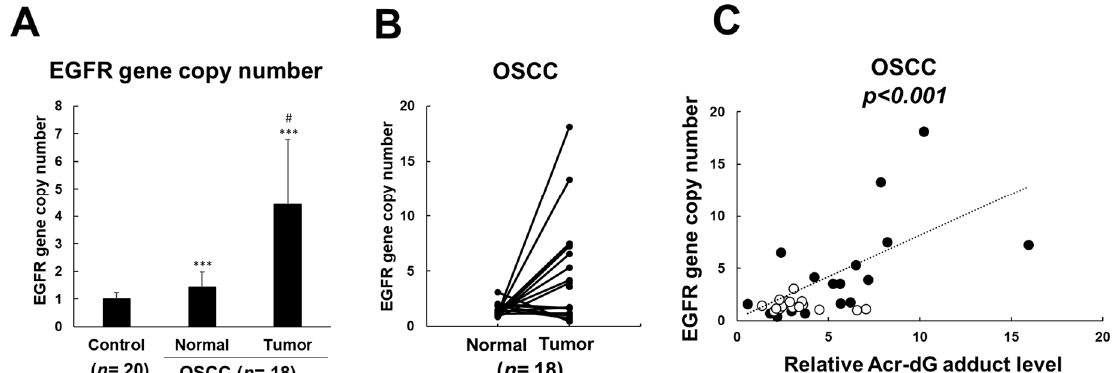
Figure 5. EGFR amplification was associated with acrolein-induced DNA damages in OSCC patients. ( A ) Gene copy number of EGFR was analyzed in buccal DNA of control subjects and tumor tissues and normal buccal DNA of 18 OSCC patients using quantitative real-time PCR. Data were expressed relative to the LINE1 gene. Student’s t -tests were used to determine statistical significance, and two-tailed p -values are shown. *** p < 0.005 compared with control subjects, # p < 0.05 compared with normal buccal DNA of OSCC patients. ( B ) Gene copy number of EGFR in tumor tissues and counterpart normal buccal DNA of 18 OSCC patients. ( C ) Correlation between EGFR gene copy number and relative acrolein levels in 18 OSCC patients was evaluated by Pearson correlation analysis ( p < 0.001). Relative acrolein-induced DNA (Acr-dG) levels in tumor tissues and counterpart normal buccal DNA of 18 OSCC patients were analyzed using slot blot analysis. Closed circle, tumor samples; open circle, normal buccal DNA.